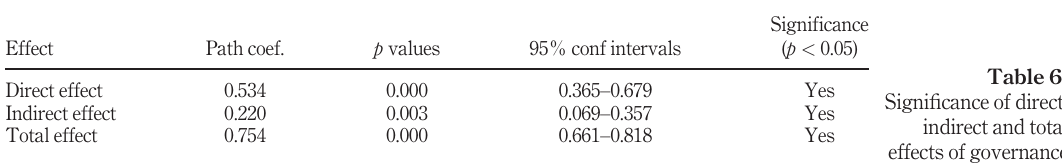
Table 6. Signi fi cance of